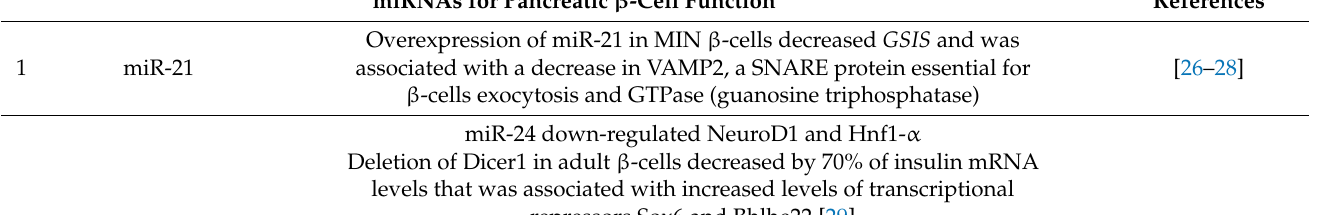
Table 1. Well-known miRNAs and their role in metabolism regulation of pancreatic development and insulin biosynthesis, secretion and signaling. miRNAs for Pancreatic β -Cell